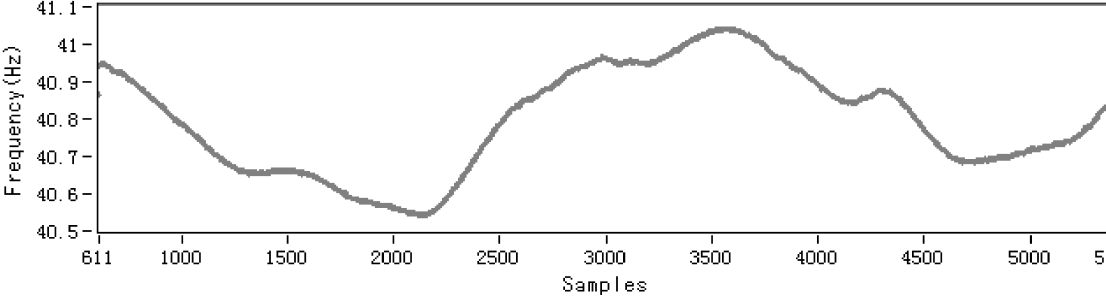
Fig. 9. The measured fundamental frequency of the